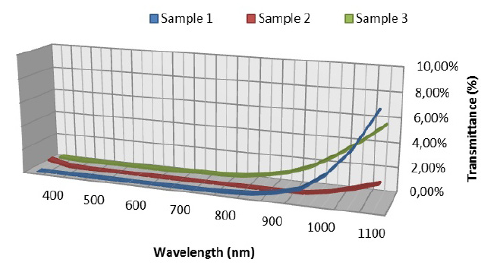
Figure 2. The transmittance curve for three CuInSe 2 films